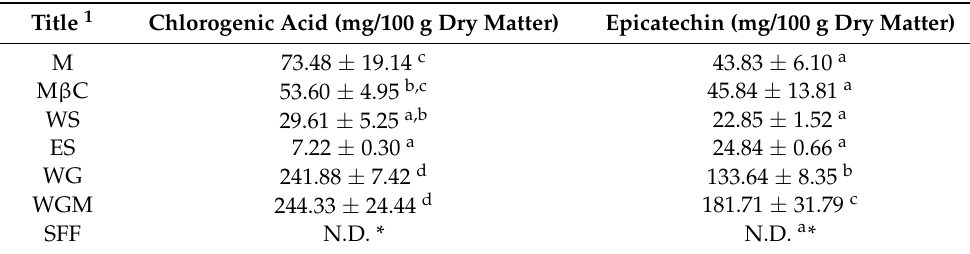
Table 2. Chlorogenic acid and epicatechin content in the avocado peel extract obtained by different extraction methods.